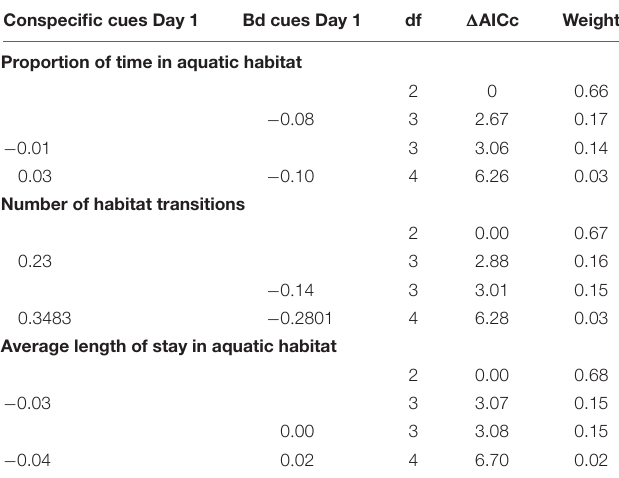
TABLE 2 | Factors influencing newt habitat use on Day 1.